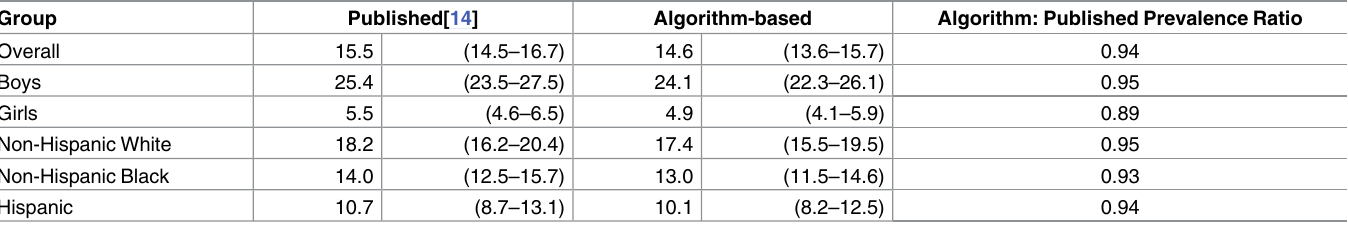
Table 2. Autism spectrum disorder (ASD) prevalenceper 1,000 children (with 95% confidence interval) for 2010 Georgia Autism and Developmen- tal Disabilities Monitoring Network site: comparison between published and algorithm-derived